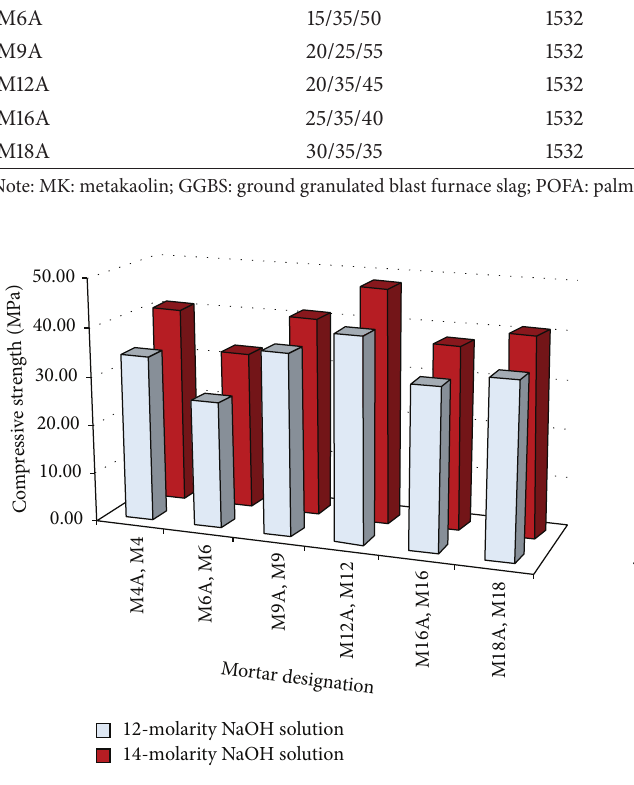
Figure 17: Effect of molarity in compressive